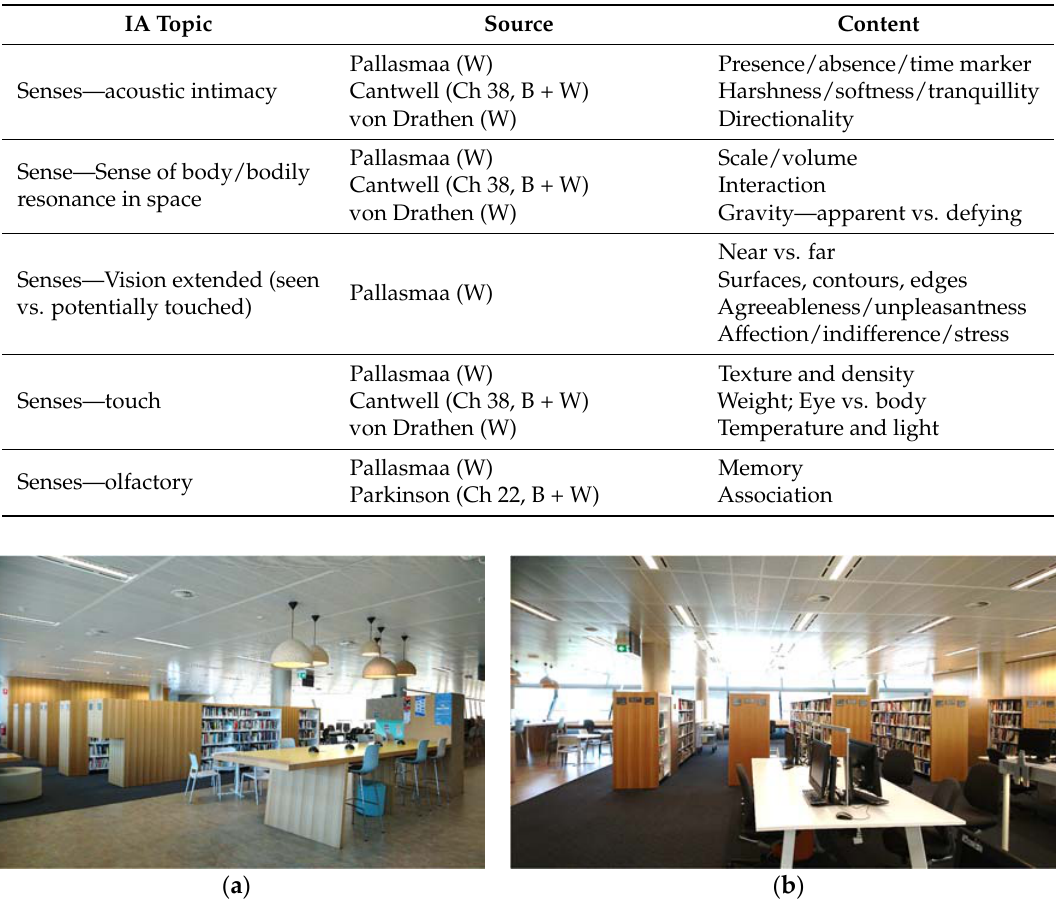
Figure 3. Level 5 northern study area, Jeffrey Smart Building, University of South Australia: ( a ) view to the southwest; and ( b ) view to the north (photos copyright of the author).